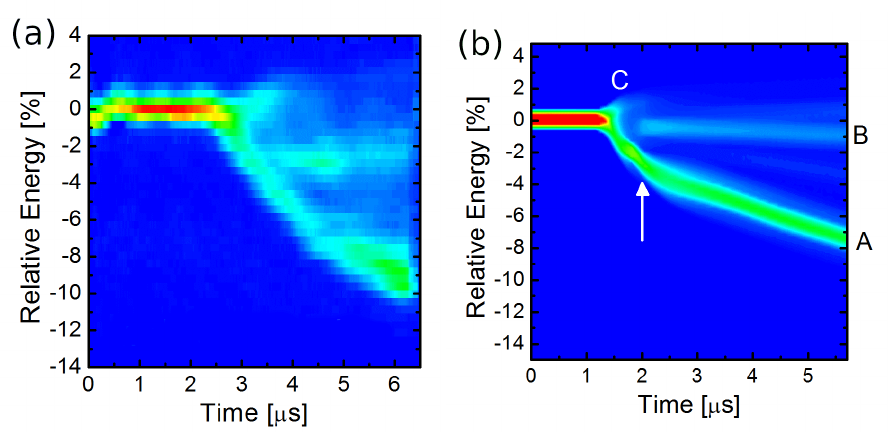
Figure 6. Evolution of the energy distribution of the spent electron beam at KU-FEL. ( a ) Experimental result with FEL lasing for the best DCD parameter. ( b ) Numerical result with the DCD parameter of 9.4 µ m. The arrow indicates the timing of the cavity detuning condition altering from 0 µ m